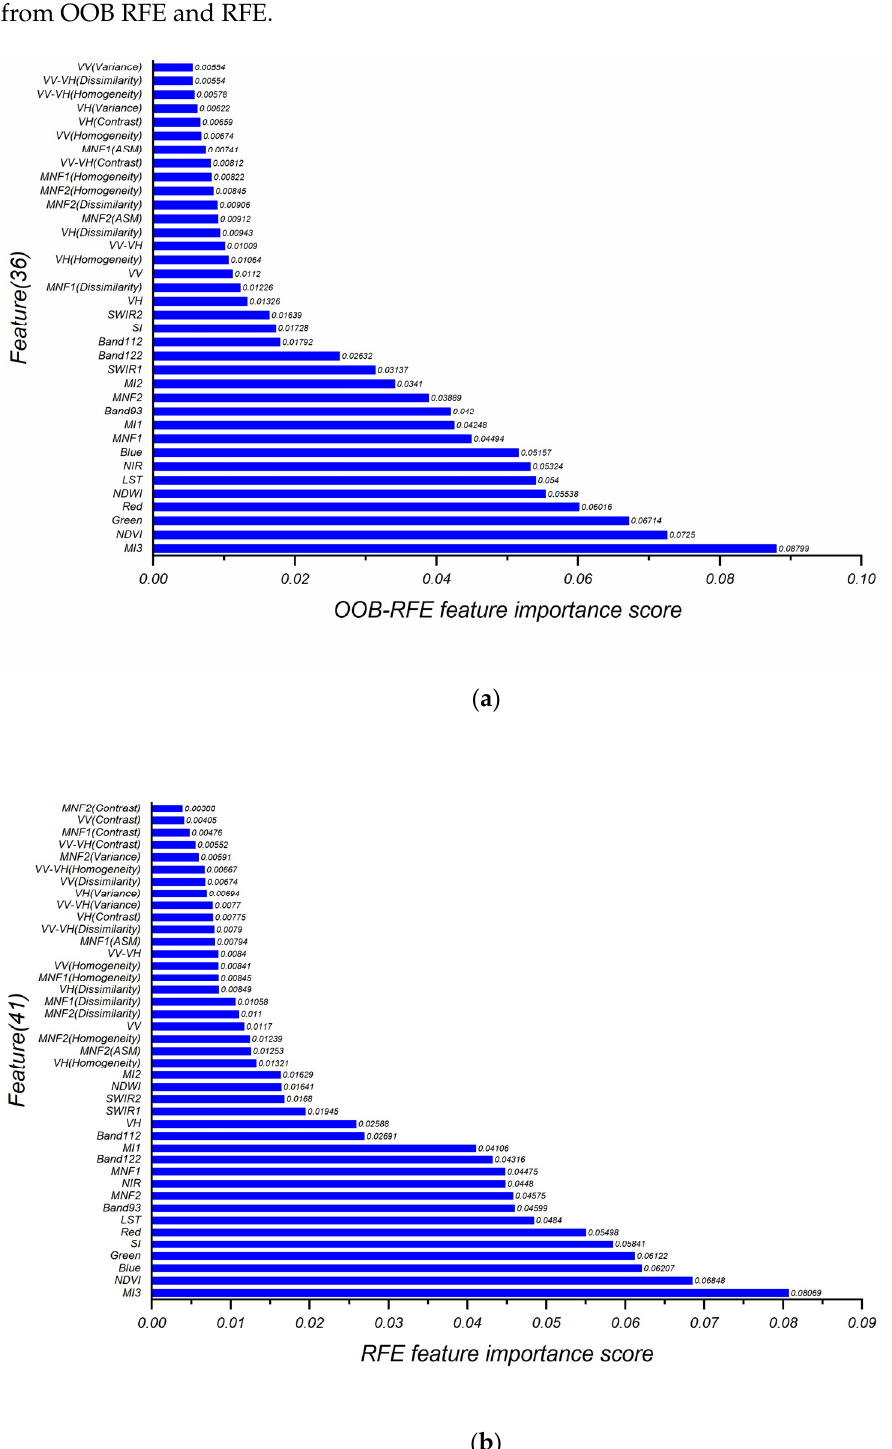
Figure 10. Feature optimization result and importance rank based on: ( a ) OOB RFE, ( b ) RFE.